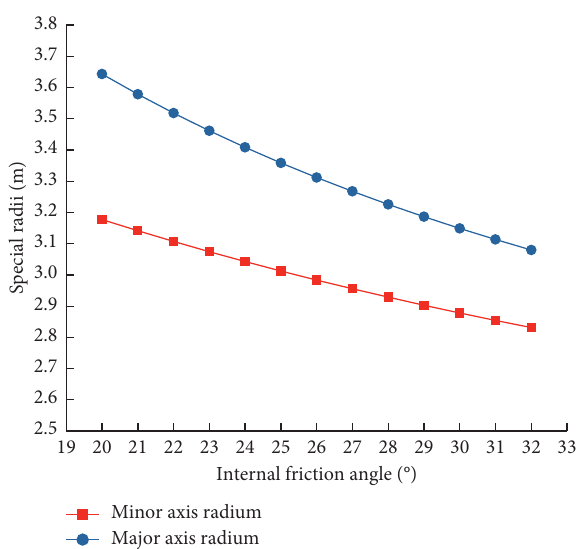
Figure 9: The relationship between special radii and internal friction angle.